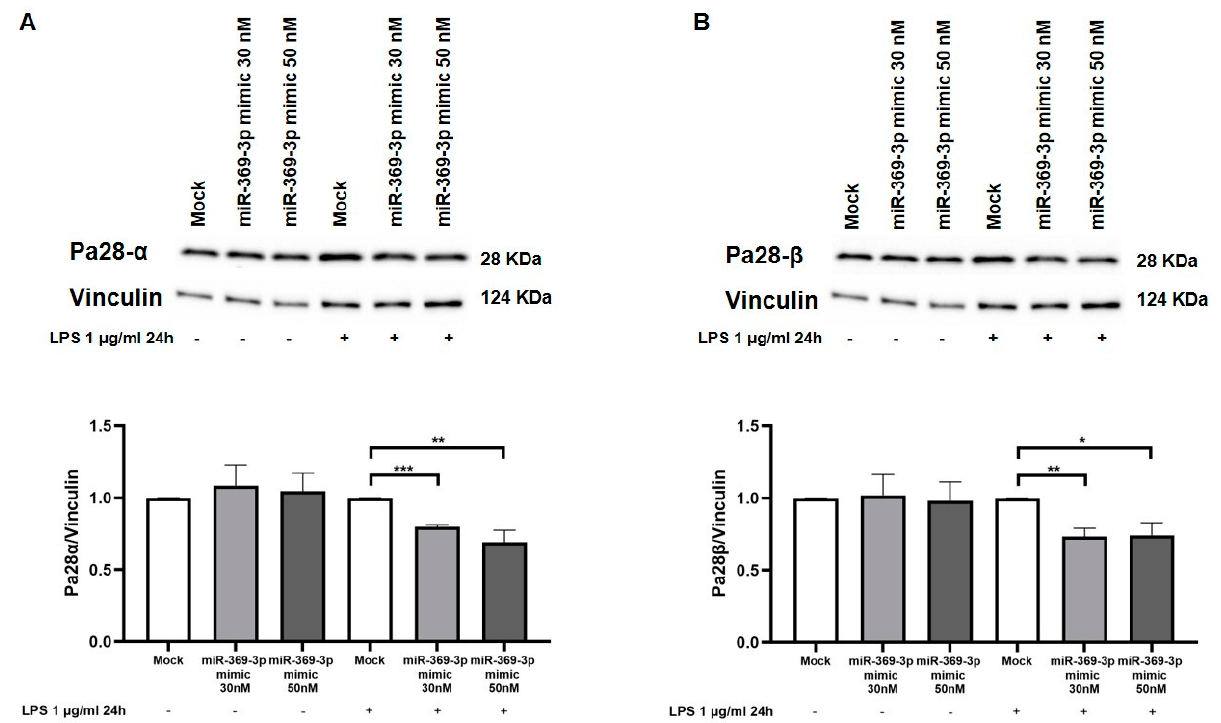
Figure 4. PA28 α and PA28 β protein expression modulated by miR-369-3p in RAW264.7 cells. Western blot analysis of PA28 α ( A ) and PA28 β ( B ) proteins after miR-369-3p mimic transfection in the RAW264.7 cell line, both unstimulated and LPS-stimulated. In basal conditions, miR-369-3p transfection did not influence the expression of these proteins. In LPS-stimulated cells, the miR-369-3p transfection resulted in a significant reduction in PA28 α and PA28 β . Vinculin was used as housekeeping protein to normalize the data. Data were obtained by comparing normalized sample values to the normalized mock sample value (* p < 0.05; ** p < 0.01; *** p < 0.001).